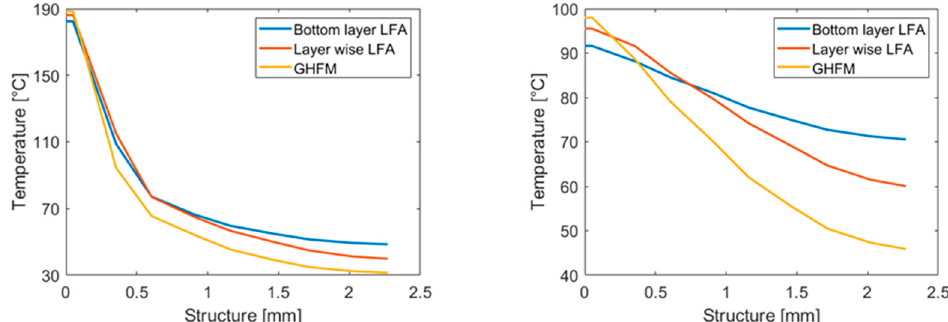
Figure 11. ( Left ) Temperature distribution immediately after the last loading cycle throughout the defined path (Figure 10). ( Right ) Temperature distribution at the end of the last unloading cycle throughout the defined path (Figure 10).